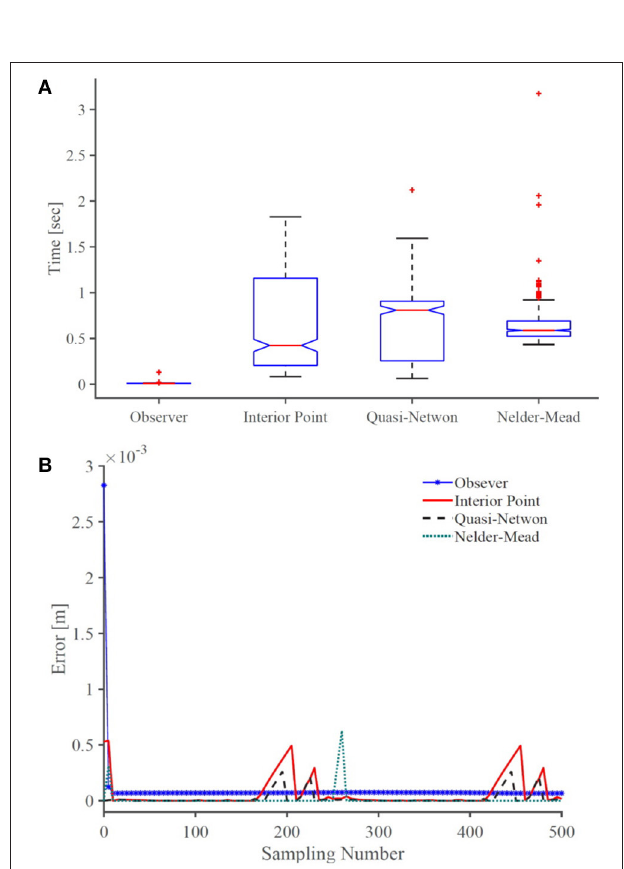
FIGURE 8 | A comparison of (A) accuracy and (B) computational efficiency of the observer with common BVP solvers. On each box in (B) , the central mark indicates the median, and the bottom and top edges of the box indicate the 25th and 75th percentiles, respectively. The whiskers extend to the most extreme data points and the outliers are plotted individually using plus